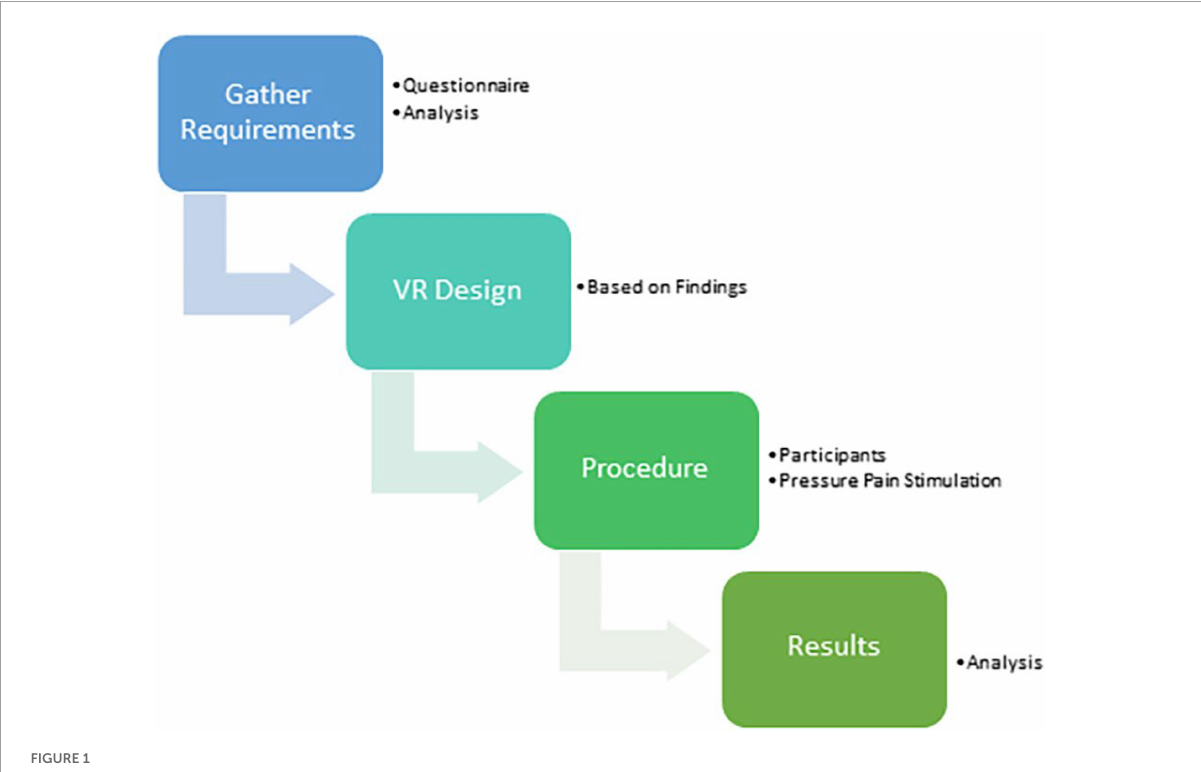
FIGURE1 Methodology steps. Image by Taima